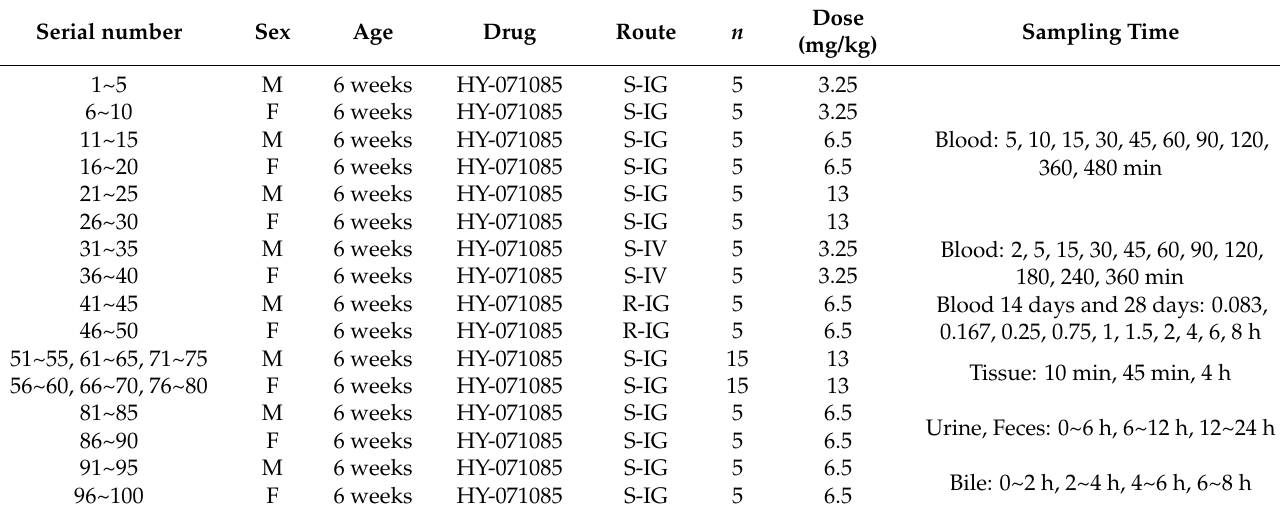
Table 5. The pharmacokinetics study design using